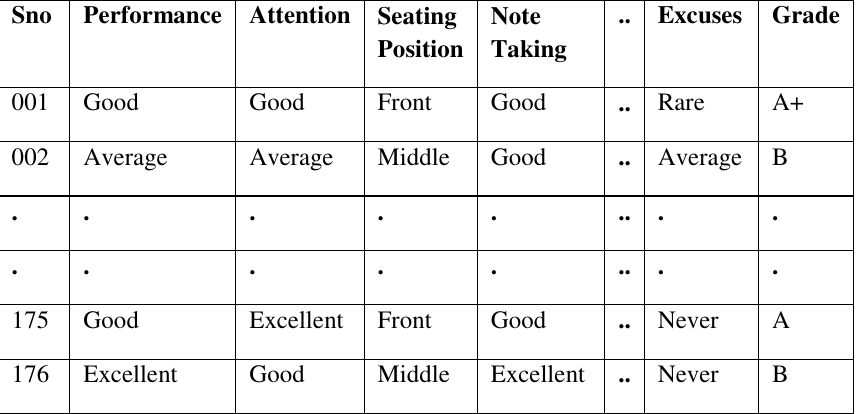
Table 1 A sample of collected student data